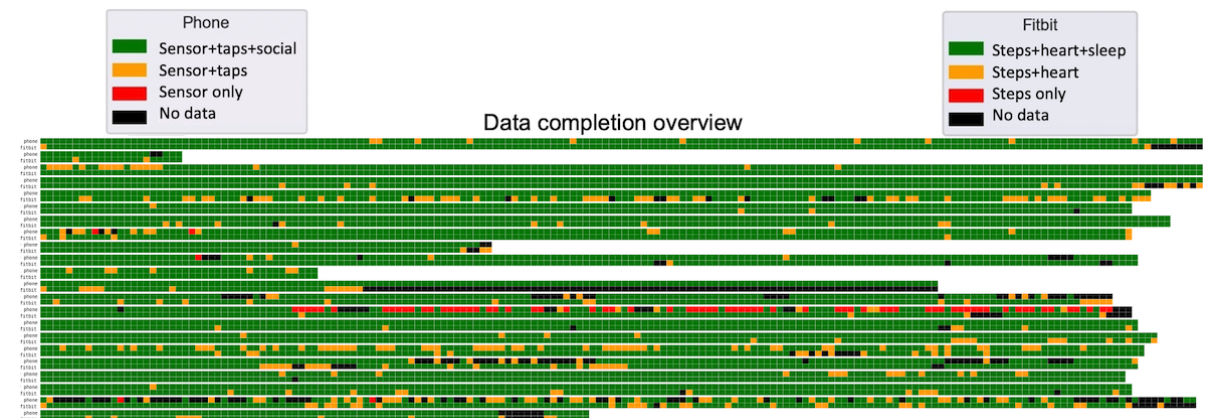
Figure 6. Data completion overview for the first 22 participants who have already completed the study (odd rows refer to phone data; even rows refer to Fitbit